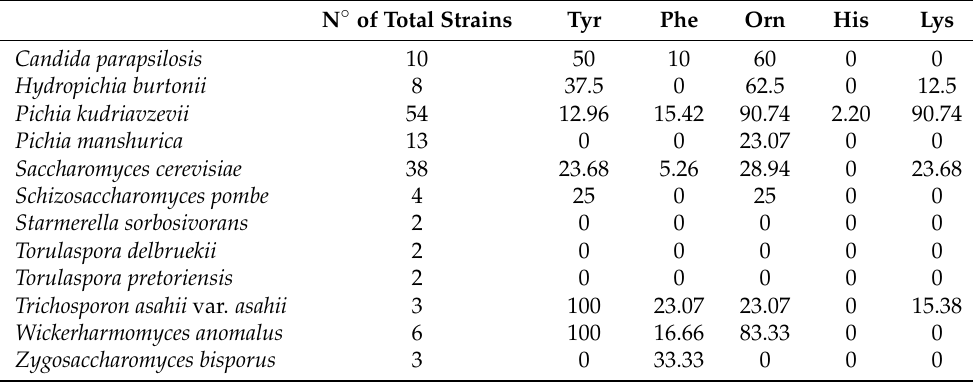
Table 1. Percentage of strains with amino acid decarboxylase activities, showed in vitro by the differ- ent yeast species isolated from fermented cocoa and dried beans. Tyr: tyrosine; Phe: phenylalanine; Orn: ornithine; His: histidine; Lys: